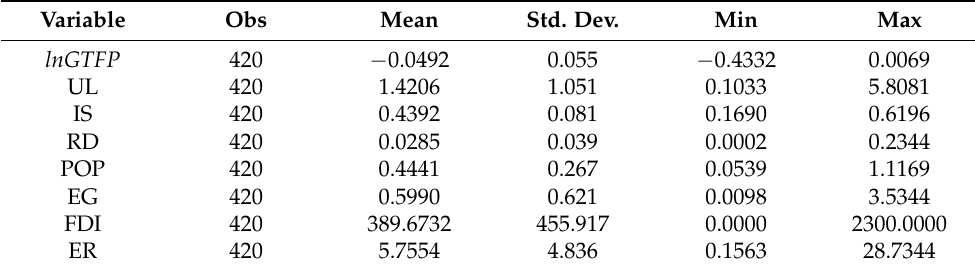
Table 2. Descriptive statistics of the full sample